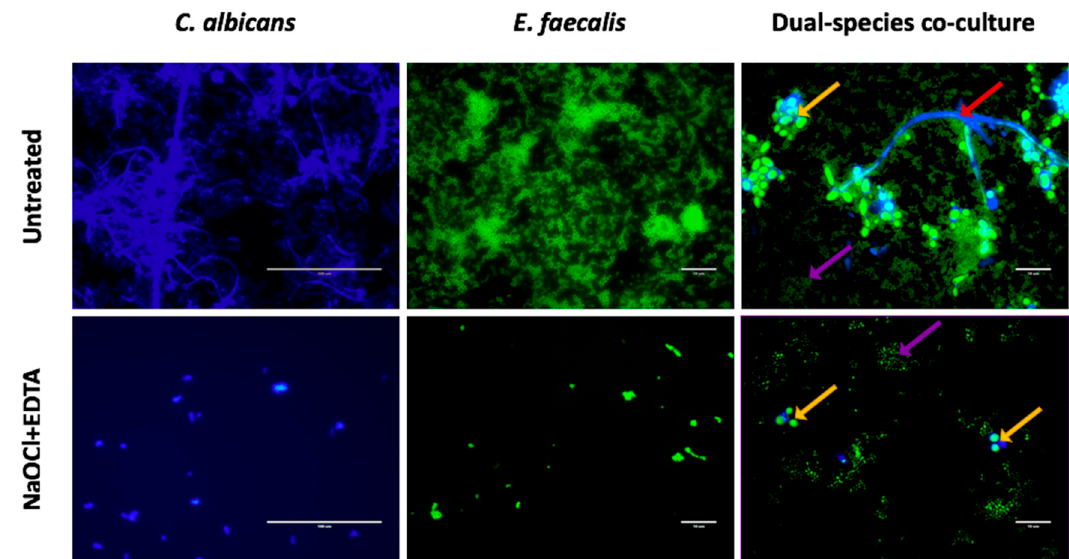
Figure 2. Fluorescence microscopic examination of C. albicans mono-species, E. faecalis mono-species and dual species biofilms. Upper panel represents untreated biofilms at 72 h. Lower panel represents regrowth of biofilms treated with NaOCl+EDTA at 72 h. C. albicans in mono-species and dual-species biofilms was stained blue with calcofluor white while the green fluorescence SYTO 9 stained both C. albicans and E. faecalis cells. Yellow arrows show C. albicans yeast cells, red arrow shows C. albicans hyphae and purple arrows show E. faecalis . Scale bars is 100 μ m in C. albicans mono-species and 10 μ m in E. faecalis mono-species and dual-species co-culture.